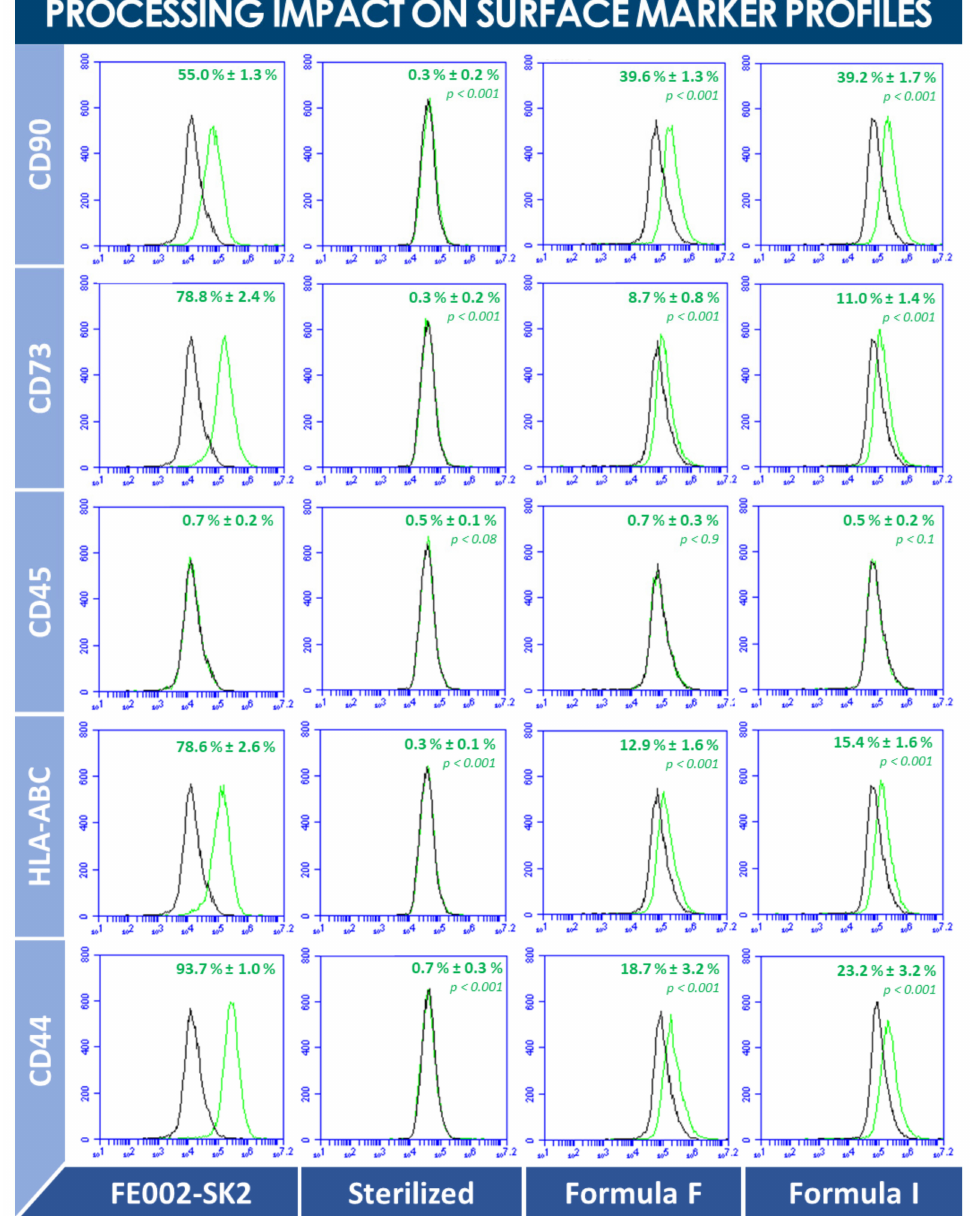
Figure 4. Comparative surface marker study results of dermal FPCs (i.e., viable cells, sterilized cells, and lyophilized cells) using FACS analysis, following EP method 2.7.24. “ Flow cytometry ”. Comparative analysis shows the effects of processing on the detection of cell surface markers. The mean percentages of detected labelled cells are specified on each plot, along with corresponding standard deviations. Statistically significant differences between quantitative data obtained for sterilized or lyophilized cells and the control group (i.e., freshly harvested cells) are indicated by p values < 0.05. Control curves are presented in black on each plot. Results indicated that while sterilization renders the detection of surface markers impossible, lyophilization of FPCs allows for qualitatively conserved specific detection thereof. Comparable quantitative data from formulas F and I were not found to be statistically different for each considered surface marker, respectively, indicating that the effect of lyophilization on cell surface markers was the same for both formulas. CD, cluster of differentiation; EP, European pharmacopoeia; FACS, fluorescence-activated cell sorting; FPC, fibroblast progenitor cells; HLA, human leukocyte